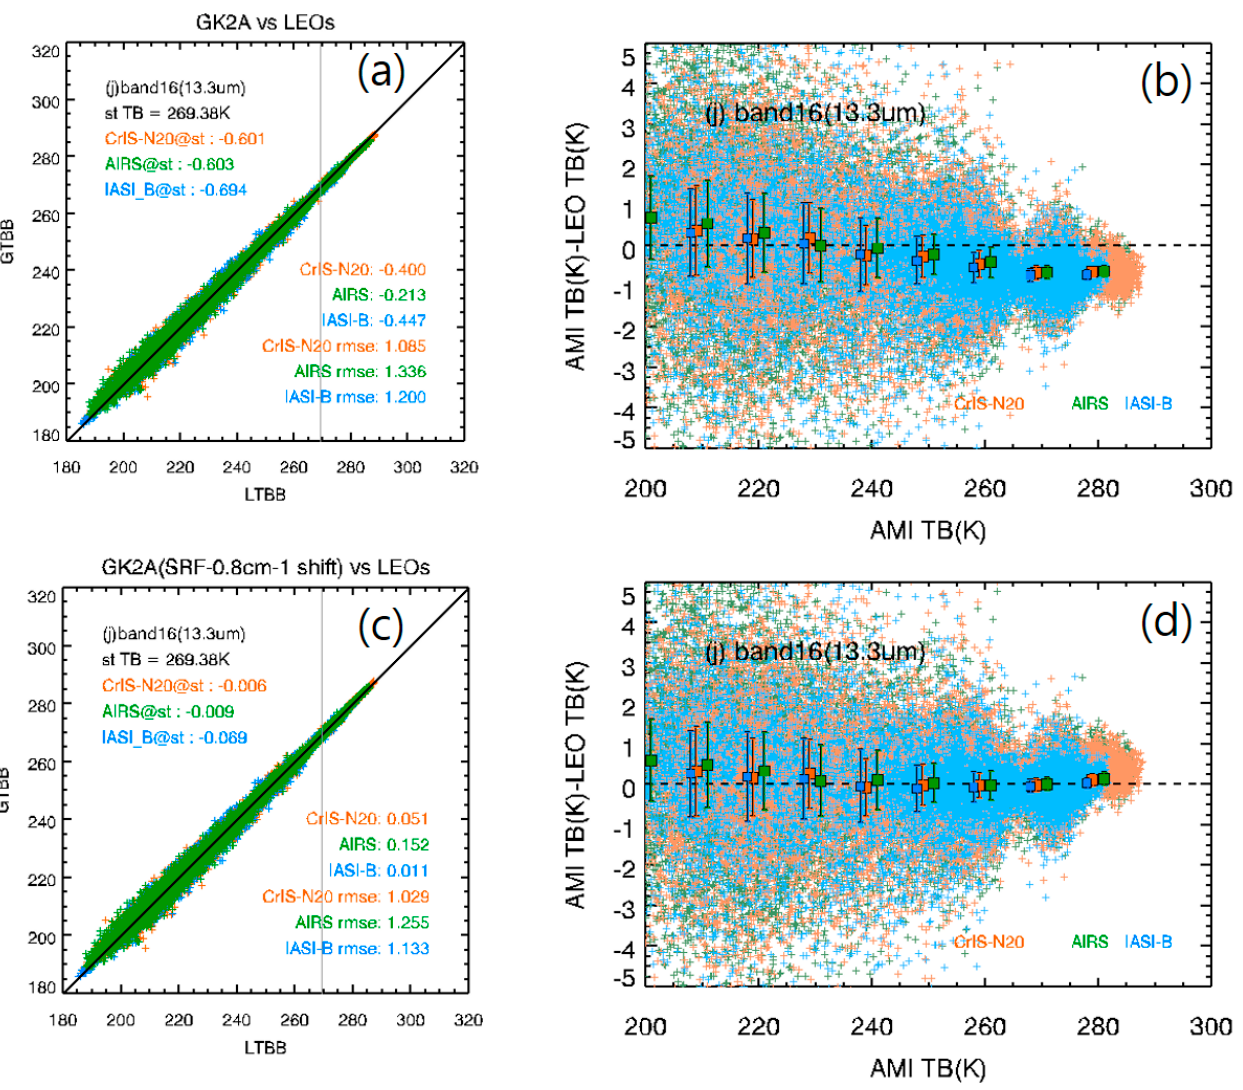
Figure 10. ( a ) Scatter plot (LEO TB vs. AMI TB) and ( b ) Δ TB(AMI-LEO) according to AMI TB with respect to MetOp-B/IASI, Aqua/AIRS, and NOAA-20/CrIS before and those ( c , d ) after applying shifted SRF.